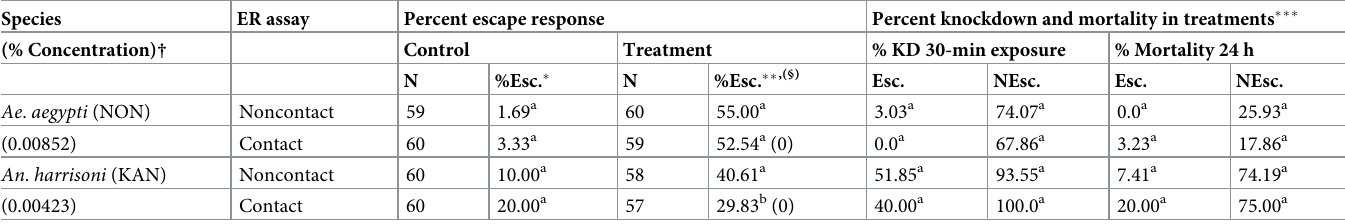
Fig 4. Comparison percentage escape patterns for (A) Ae . aegypti USDA strain and Nonthaburi (NON) field population, and (B) An . minimus DDC strain and An . harrisoni Kanchanaburi (KAN) field population in contact and noncontact ER assays. Escape responses recorded at 1-min intervals during 30-min exposure to TFT at LC 50 established for each laboratory strain [40]. Concentration for An . minimus applied for An . harrisoni . Paired control escape responses not shown.